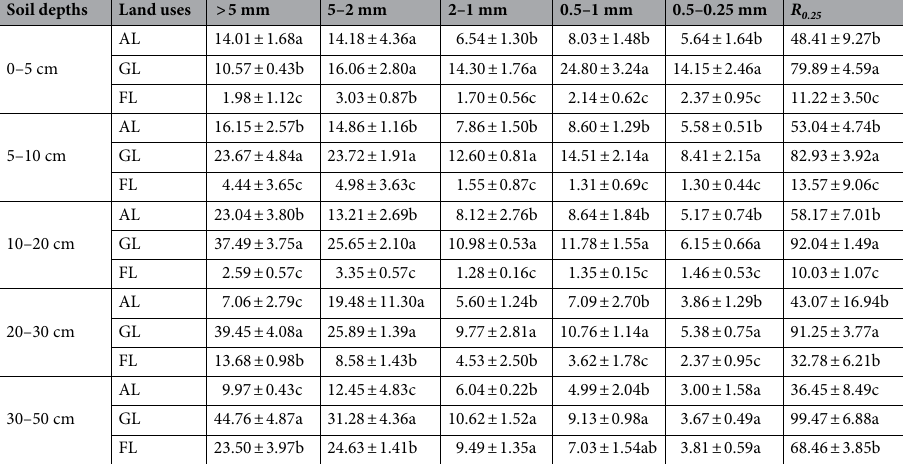
Table 2. Effect of land uses on soil dry-stable aggregates (%) at different depth (mean ± SD). Different letters with the same soil depth indicate significant difference (n = 5, p < 0.05) between different land uses by one-way ANOVA. R 0.25 is aggregates of diameter > 0.25